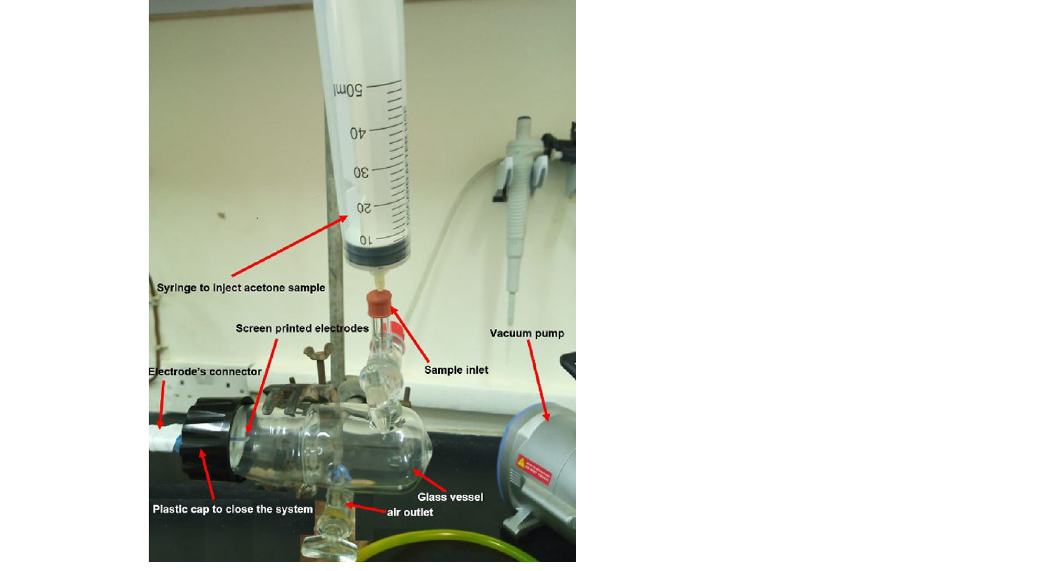
Figure 3. A complete setup for the closed glass